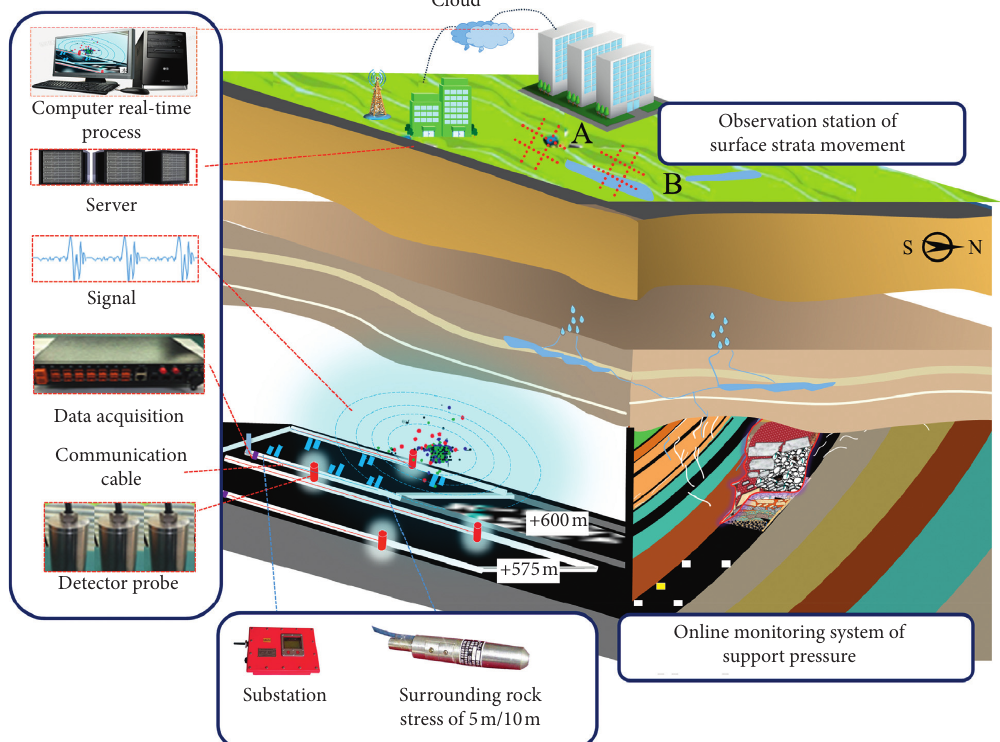
Figure 14: Long-term monitoring of roof dynamic by microseismic